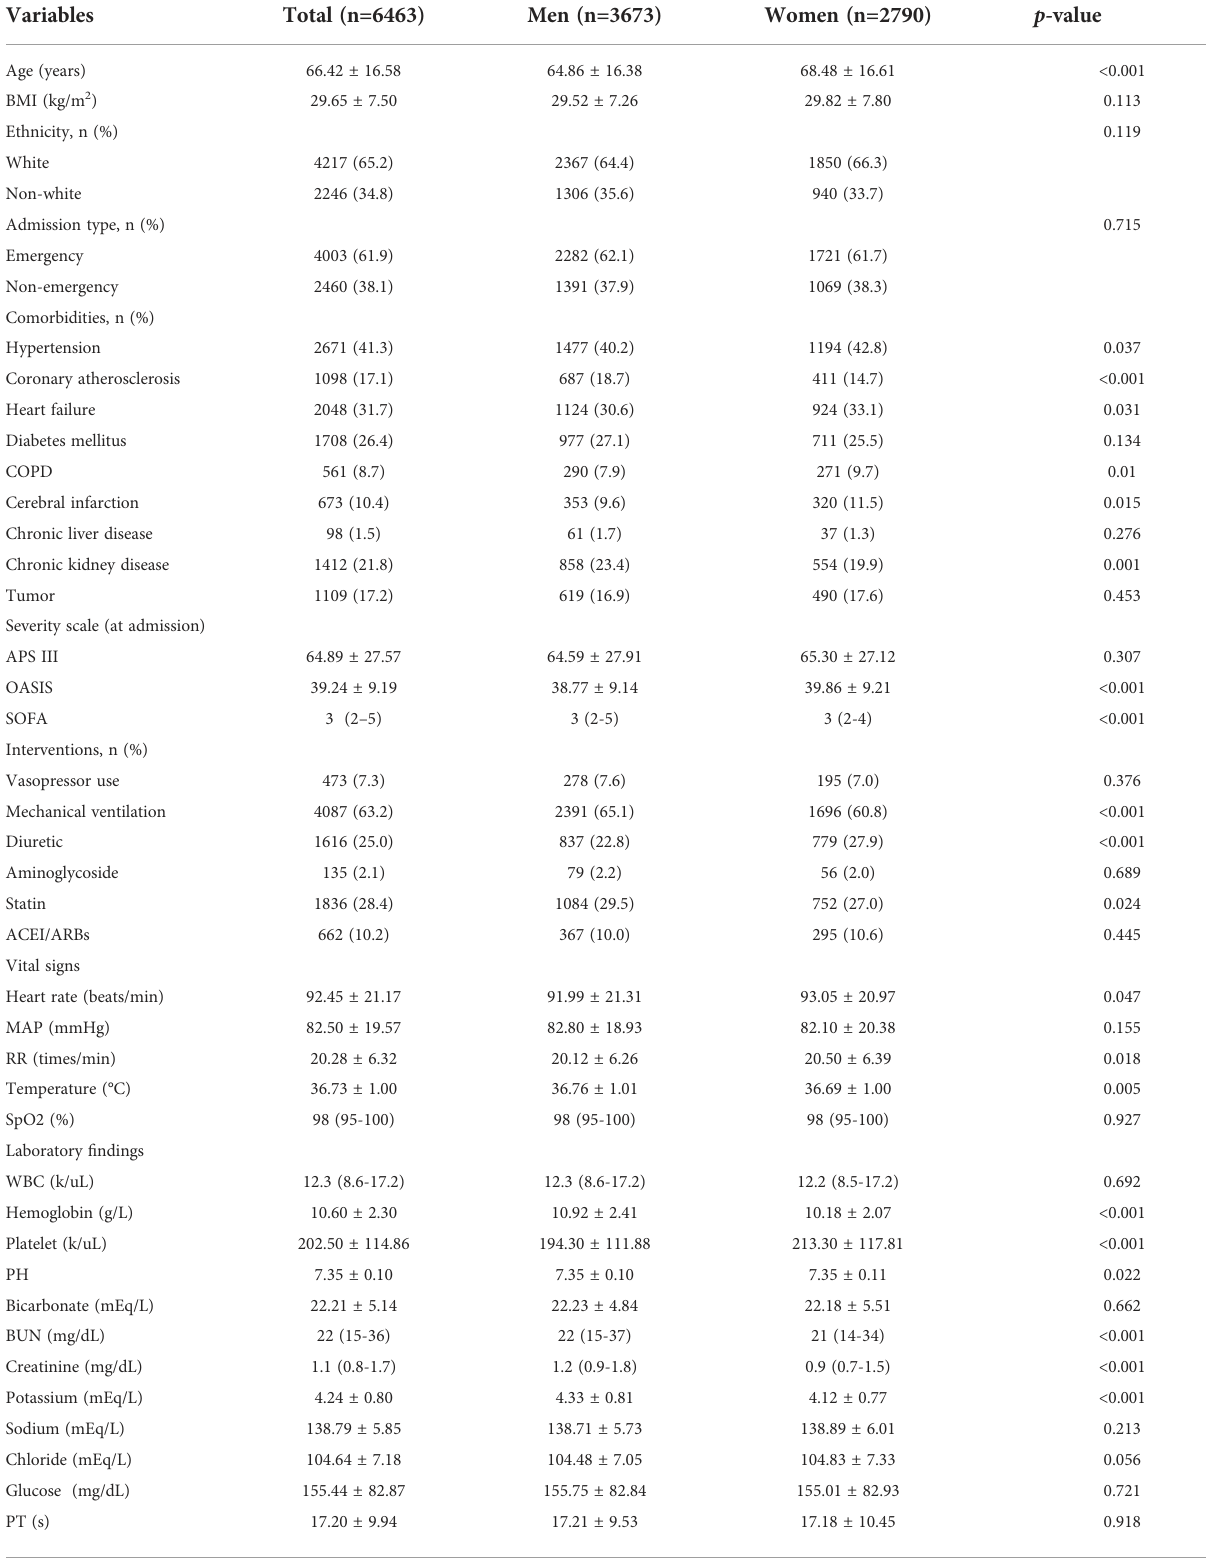
TABLE 1 Baseline characteristics of